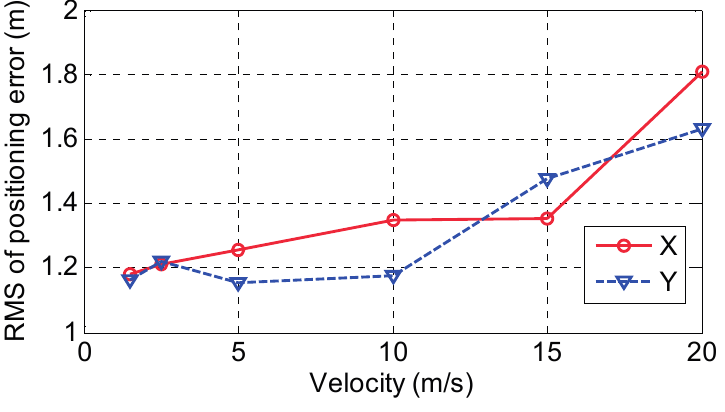
Figure 12. Positioning error variation with